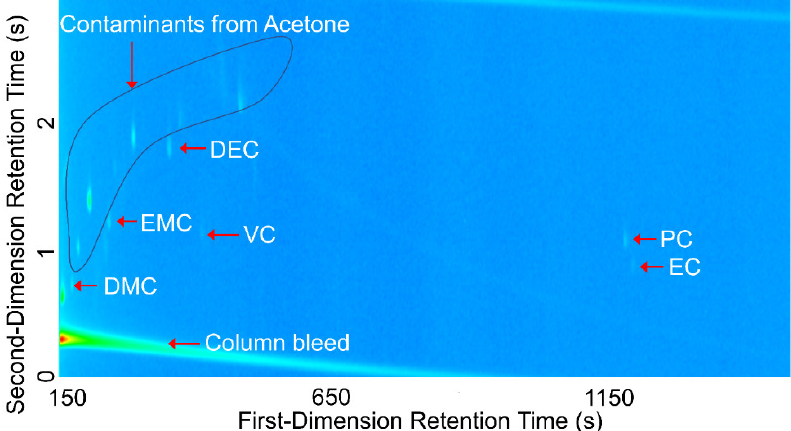
Figure 3. GC × GC/FID chromatogram of 0.2% ( v / v ) solution of DMC, EMC, DEC, VC, PC, and EC in acetone.